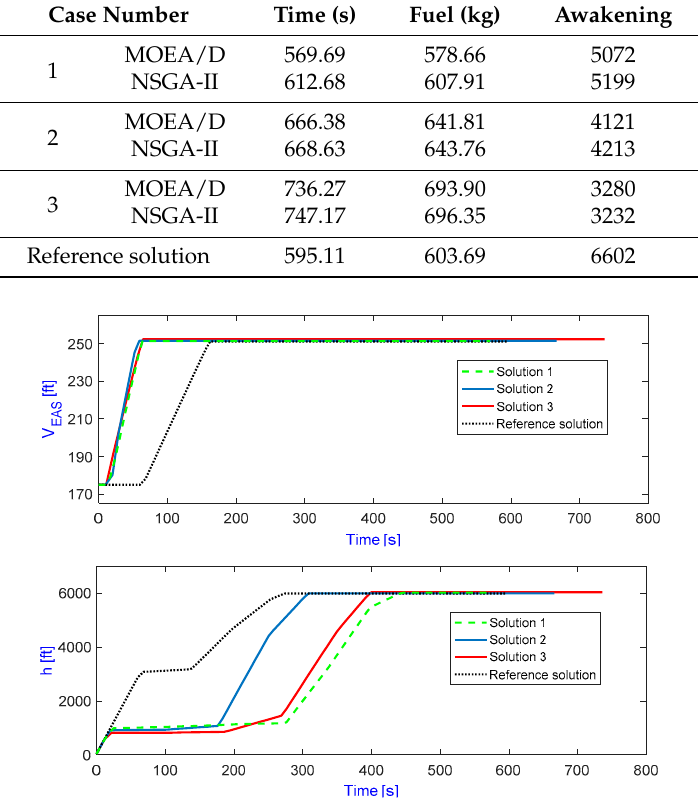
Table 1. Comparison of objectives of cases 1–3 and the reference case.